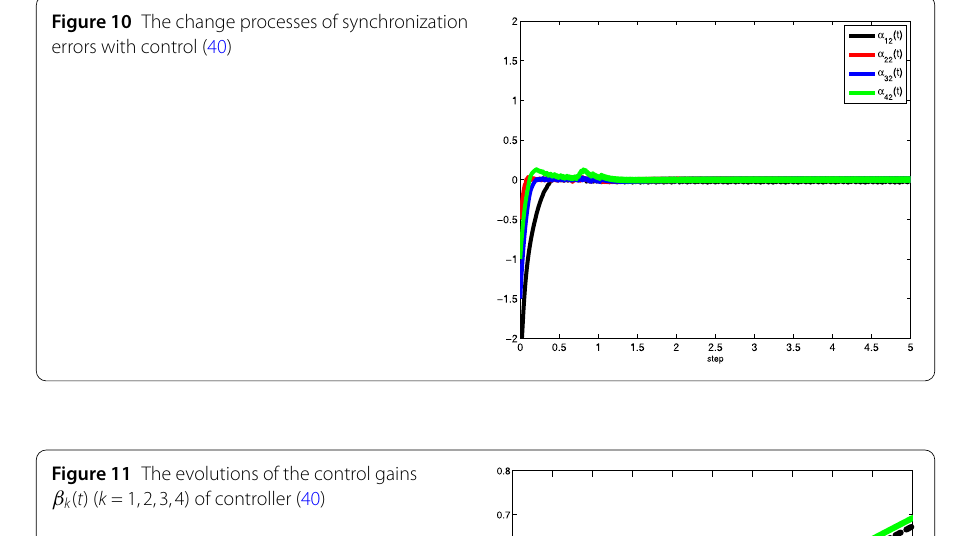
Figure 11 The evolutions of the control gains β